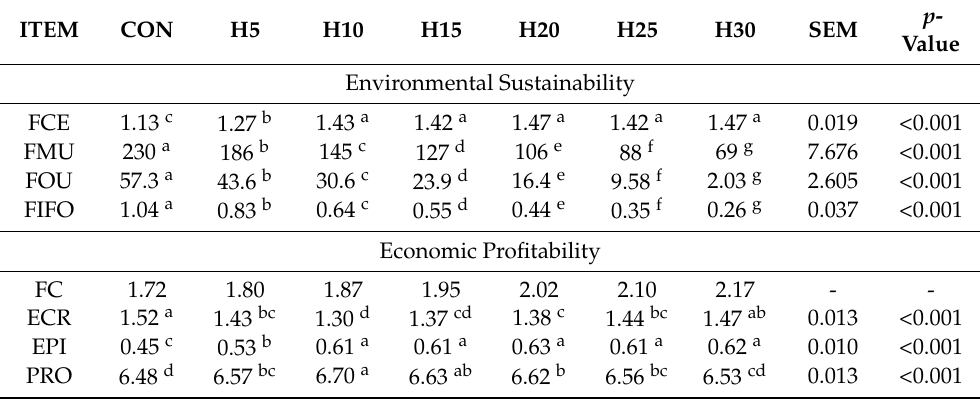
Table 2. Sustainability and economic assessment of Siberian sturgeon production with the use of experimental diets containing increasing share of black soldier fly full-fat larvae